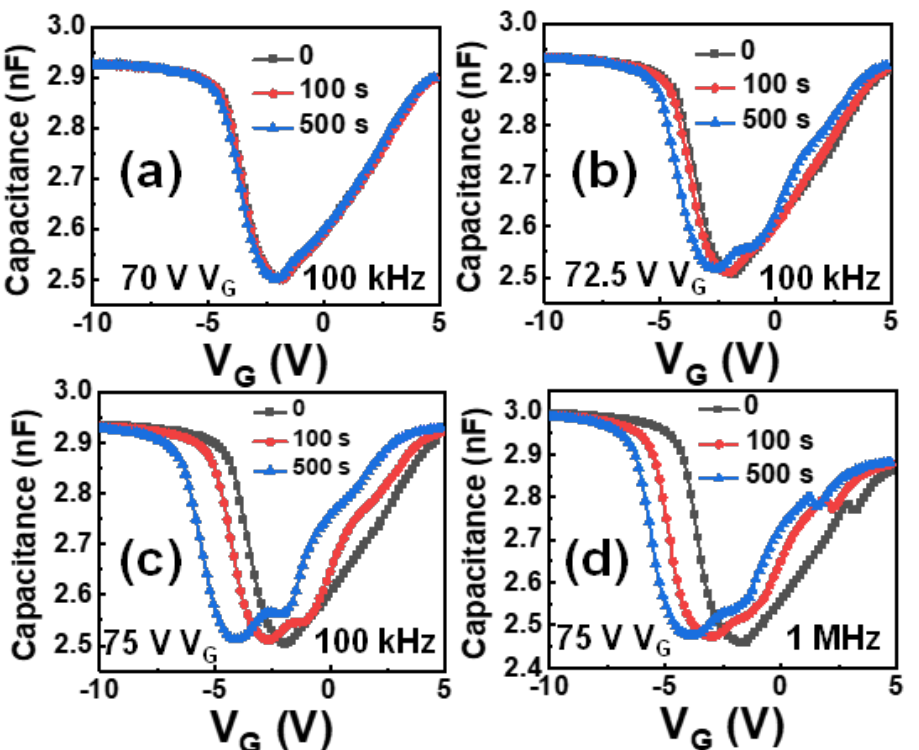
Figure 7. Variations of C-V curves measured at 100 kHz with ( a ) 70 V, ( b ) 72.5 V, and ( c ) 75 V stress voltage after stress time of 0 s, 100 s, and 500 s. ( d ) Variations of C-V curves (1 MHz) with 75-V gate voltage after stress time of 0 s, 100 s, and 500 s.